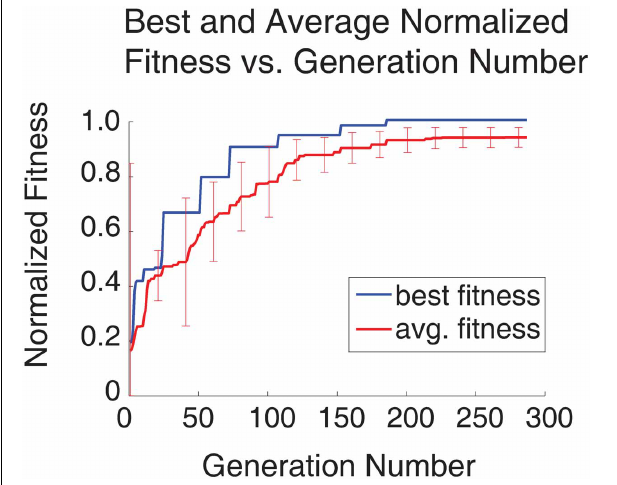
FIGURE 4 | Plot of best and average fitness vs. generation number for entire simulation run (287 generations, 4104 neuron SNNs, 10 parallel configurations). All values were normalized to the best fitness value. The error bars denote the standard deviation for the average fitness at intervals of once per 20 generations. Initially the standard deviation of the average fitness is large as the EA explores the parameter space, but over time, the standard deviation decreases as the EA finds better solutions.